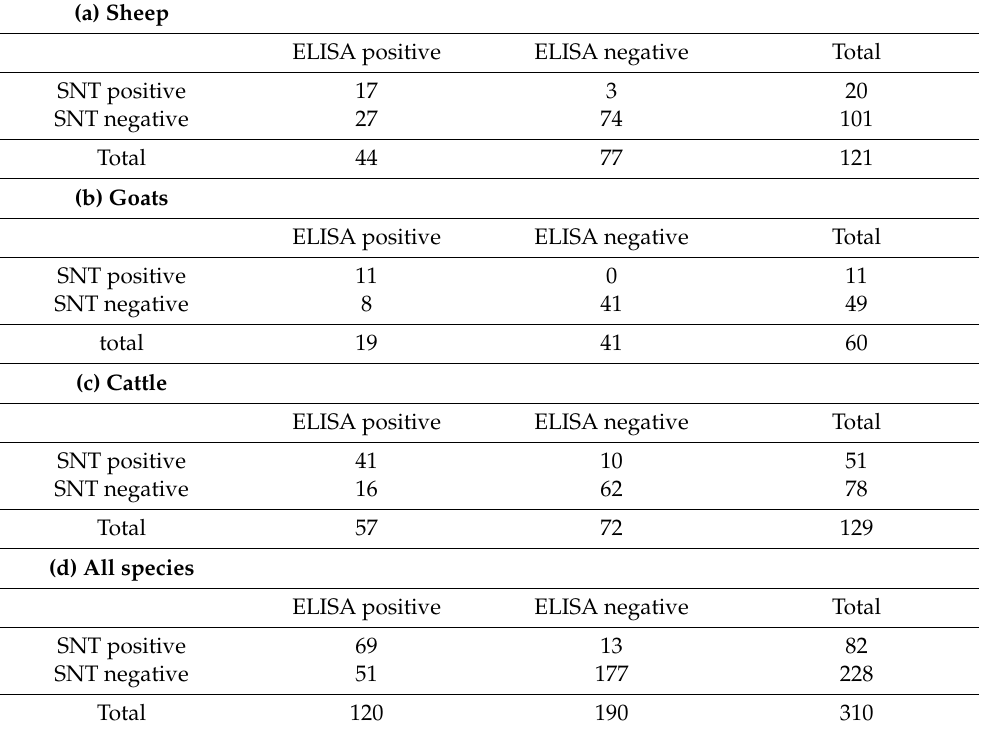
Table 2. Summary of SNT and indirect ELISA results for each species: (a) sheep, (b) goats, (c) cattle, and (d) in